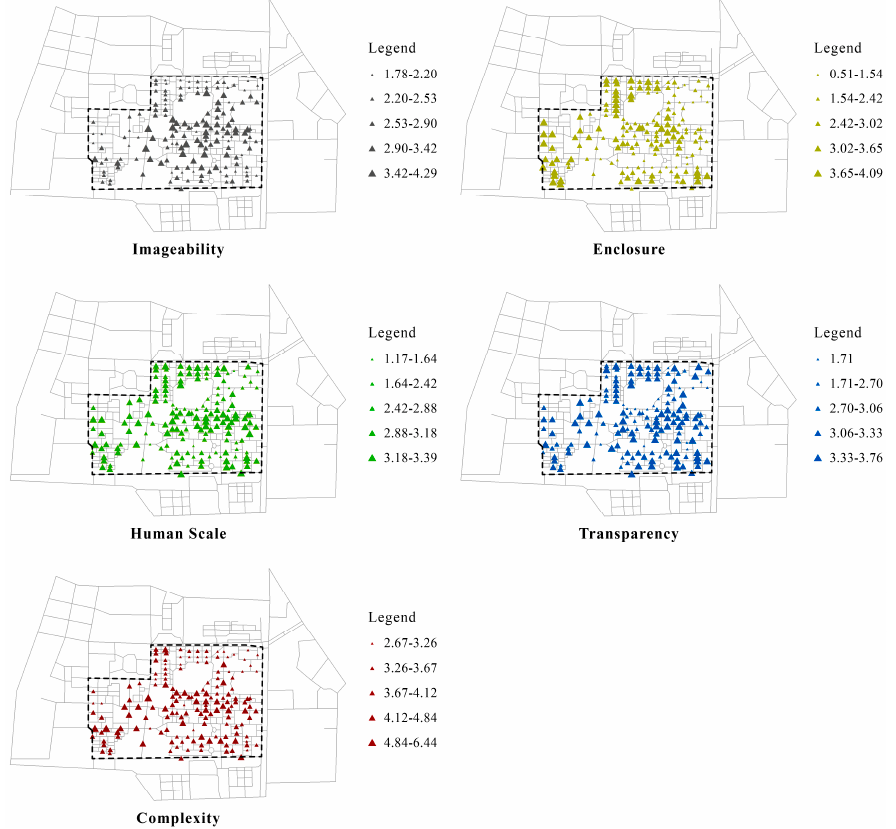
Land 2023 , 12 , x FOR PEER REVIEW